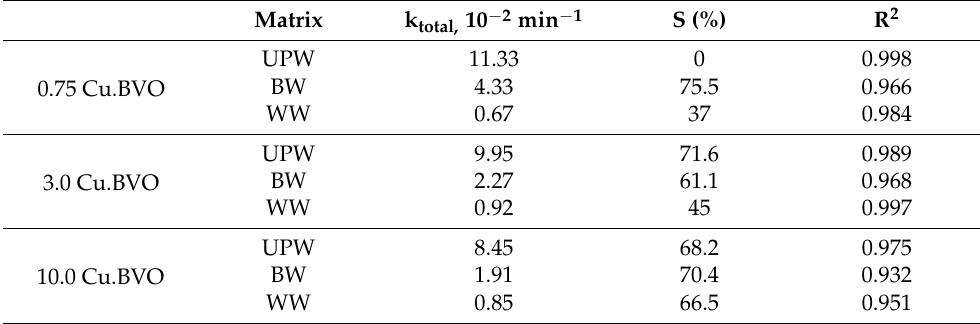
Table 1. Apparent kinetic constants and synergy degree for all CuO x loadings examined in UPW, BW, and WW.